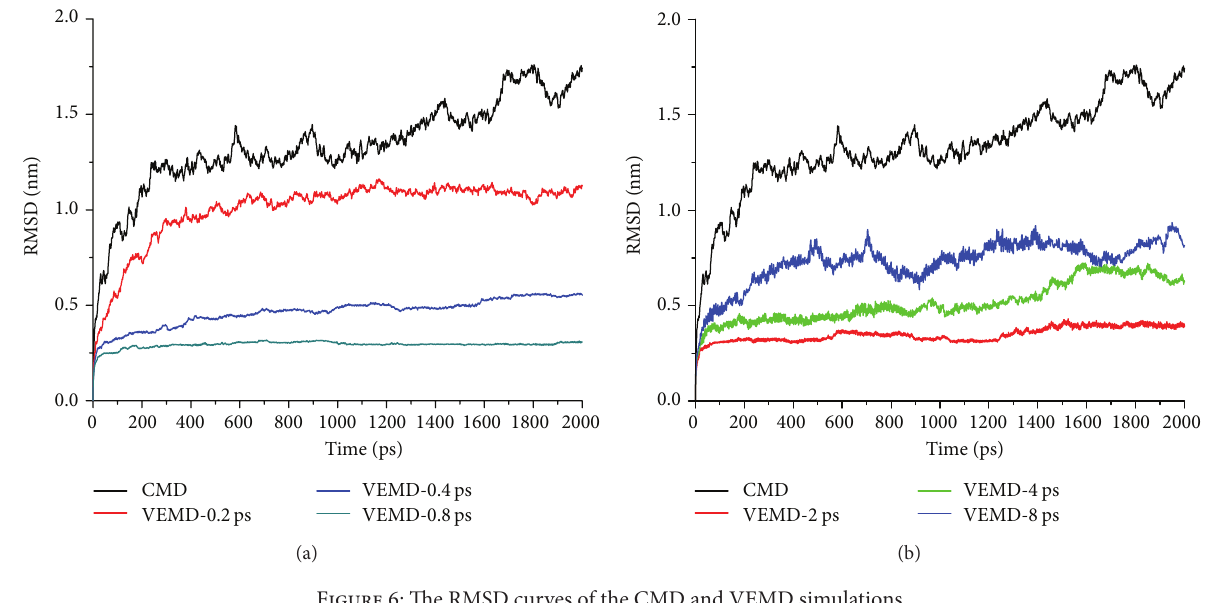
Figure 6: The RMSD curves of the CMD and VEMD simulations.